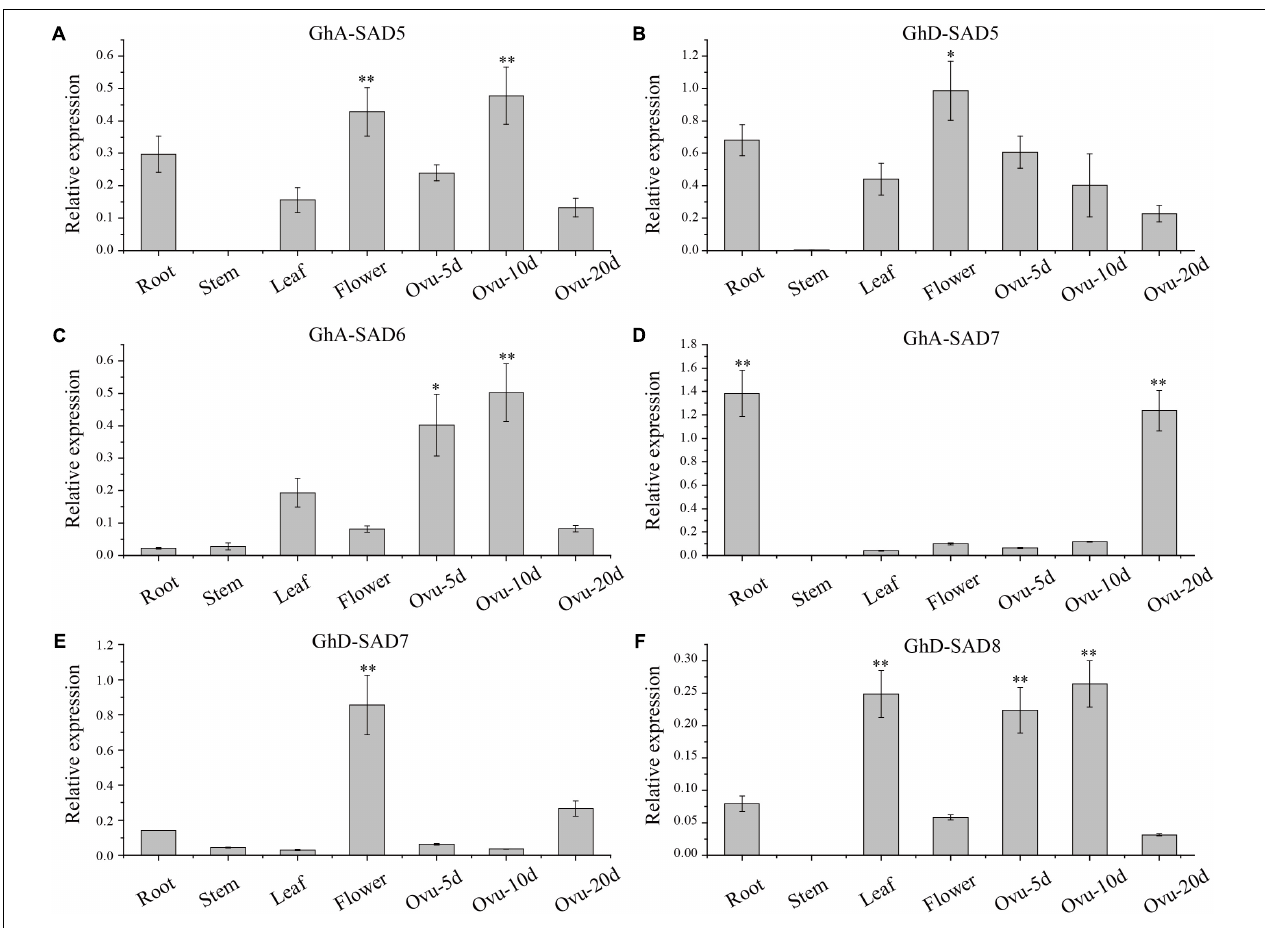
FIGURE 4 | Deduced GhSAD expression patterns of GhA-SAD5 (A) , GhD-SAD5 (B) , GhA-SAD6 (C) , GhA-SAD7 (D) , GhD-SAD7 (E) , and GhD-SAD8 (F) in various cotton tissues. Bar charts show the relative expression levels of GhSAD genes normalized to that of Histone3 and EF-1 α measured by qRT-PCR. The analysis was performed with three biological samples for each tissue. Ovu-5d, 10d and 20d represent 5, 10, and 20 DAF of developing cottonseed ovules. The method of 2 − (cid:49)(cid:49) cq was used in this analysis. “ ∗ ” represents statistically significant difference values of P < 0.05 and “ ∗∗ ” for P < 0.01 based on two-tailed Student’s t -tests.